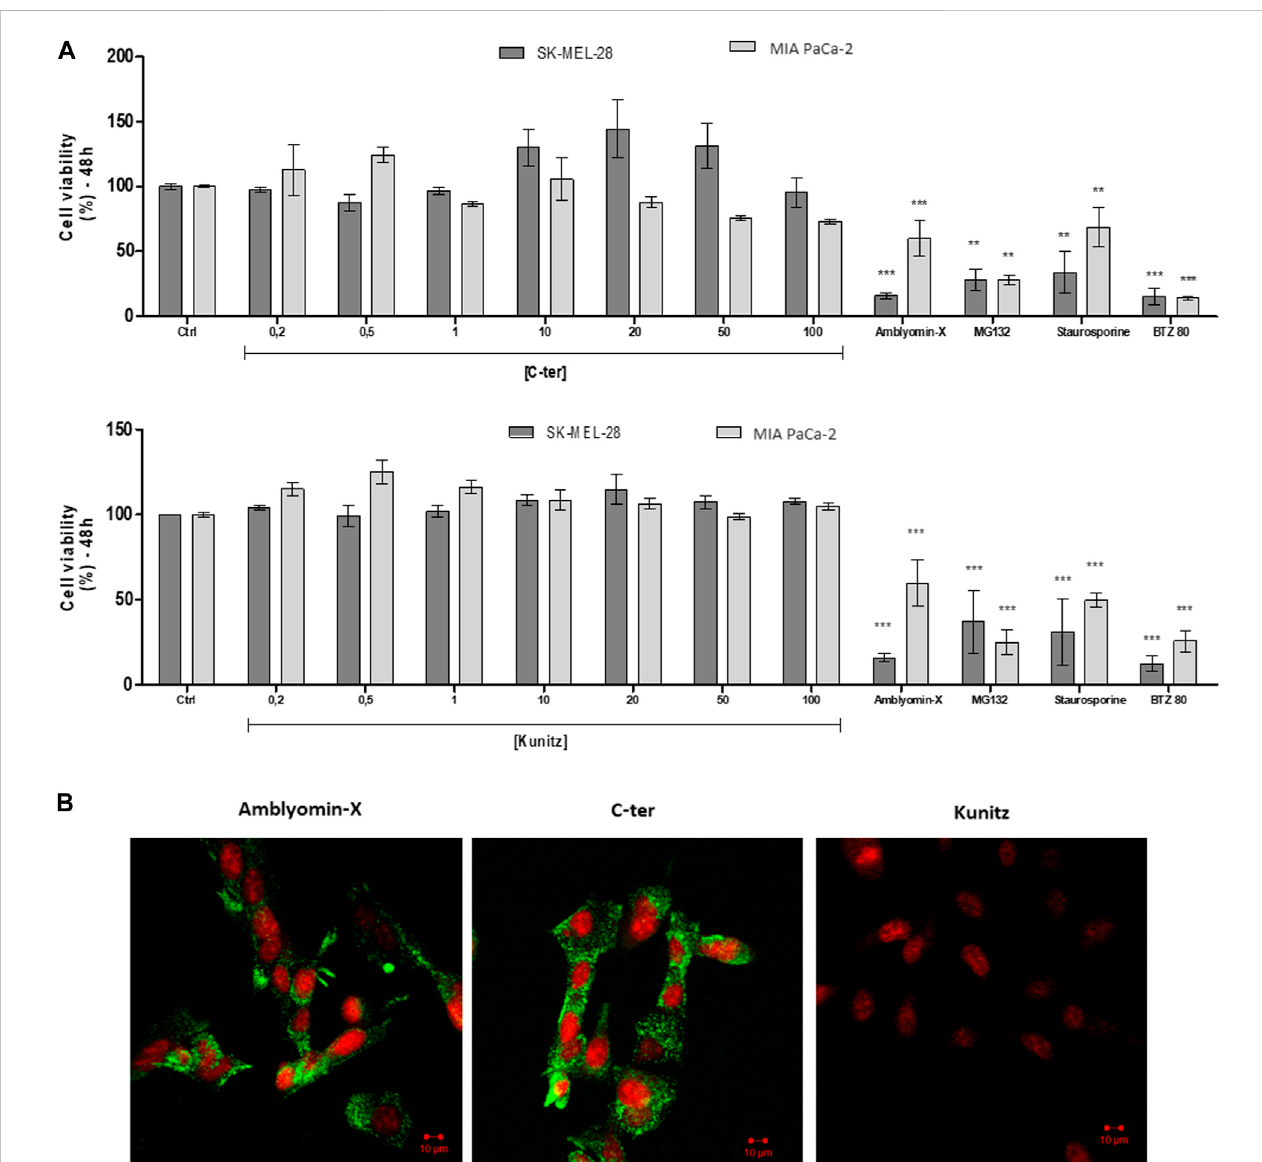
FIGURE 3 Amblyomin-X-induced cytotoxicity, but not of the isolated domains. (A) After 48 h, cell viability of tumor cells (SK-MEL-28 and MIA PaCa-2) was measured by MTT using increasing concentrations (µM) of C-ter and Kunitz. Positive controls: 20 µM full-Amblyomin-X, 5 µM staurosporine, 80 nM bortezomib (BTZ80) and 5 µM MG132. (B) Cells were incubated with 488-C-ter, 488-Kunitz or 488-Amblyomin-X (all at 20 µM), for 4 h. Green fl uorescence was monitored with confocal laser scanning microscopy. Nuclei were stained with Syto59 (5